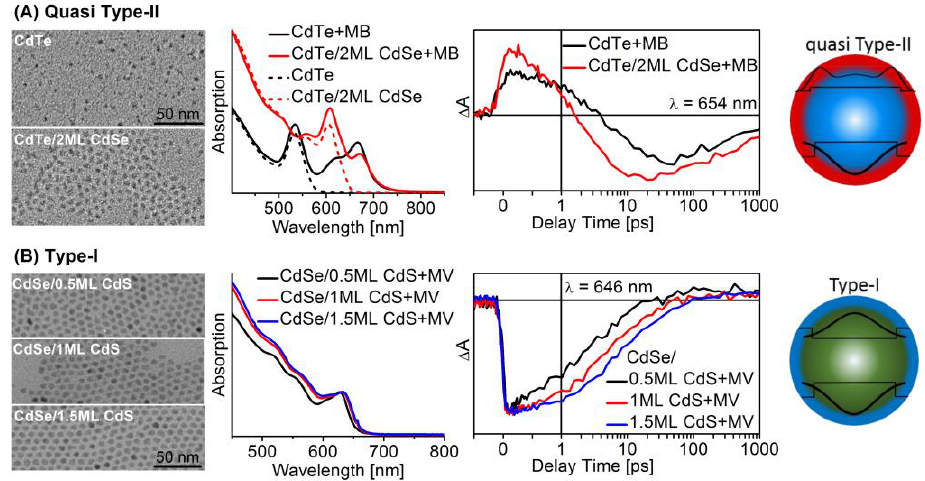
Fig. 1. Transmission electron micrographs of (A) CdTe and CdTe/2ML CdSe, and (B) CdSe/CdS with different shell thicknesses. Absorption spectra of (A) CdTe, CdTe/2ML CdSe and the corresponding complexes with MB, and (B) MV-CdSe/CdS complexes (different CdS shell thicknesses). TA traces of (A) MB-CdTe and MB-CdTe/2ML CdSe complexes, and (B) MV- CdSe/CdS complexes (different CdS shell thicknesses). Scheme of the electron and hole wave functions of (A) CdTe/CdSe quasi type-II HNS and (B) CdSe/CdS type-I